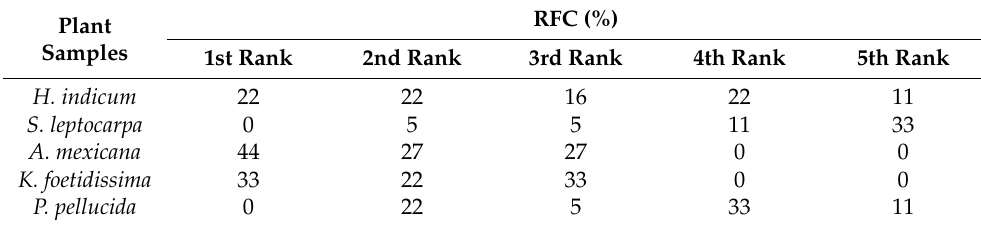
Table 3. Factors causing the scarcity of plant samples reported as quite rare by traders.